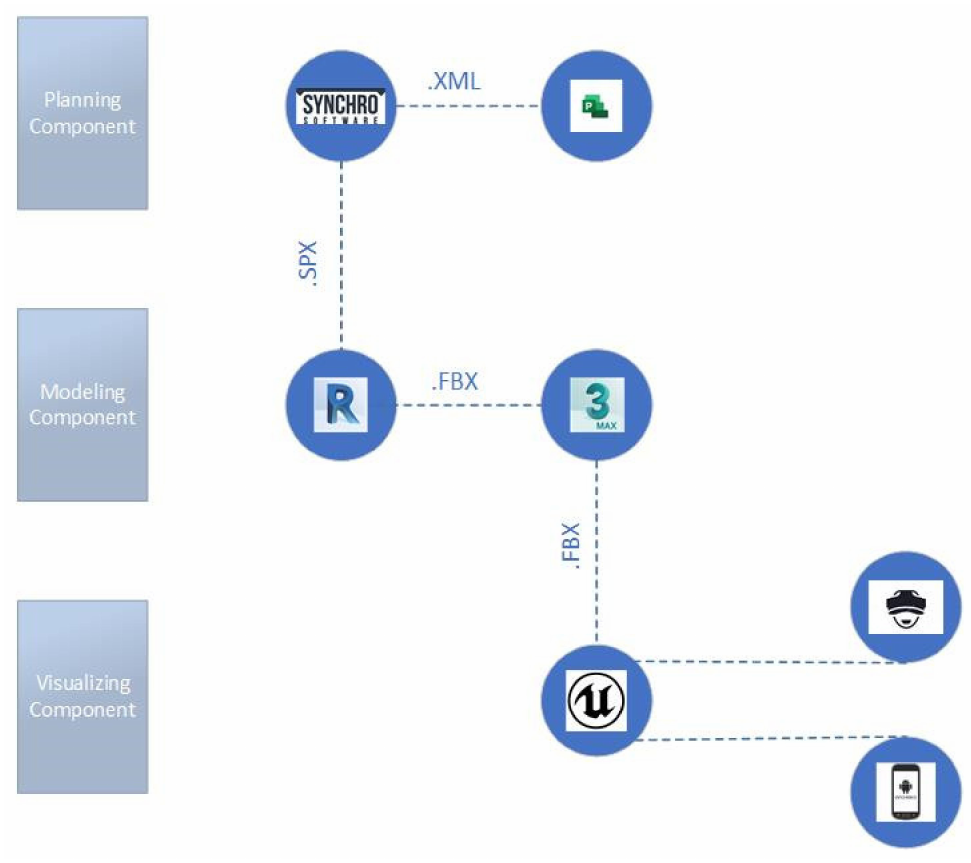
Figure 4. Simulation module and file exchange within the